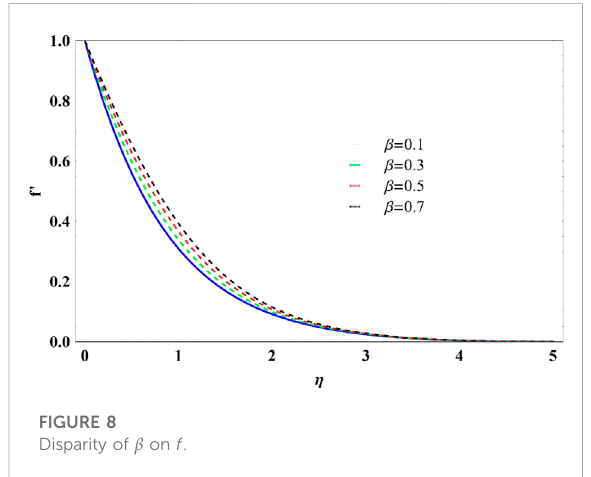
FIGURE 8 Disparity of β on f .